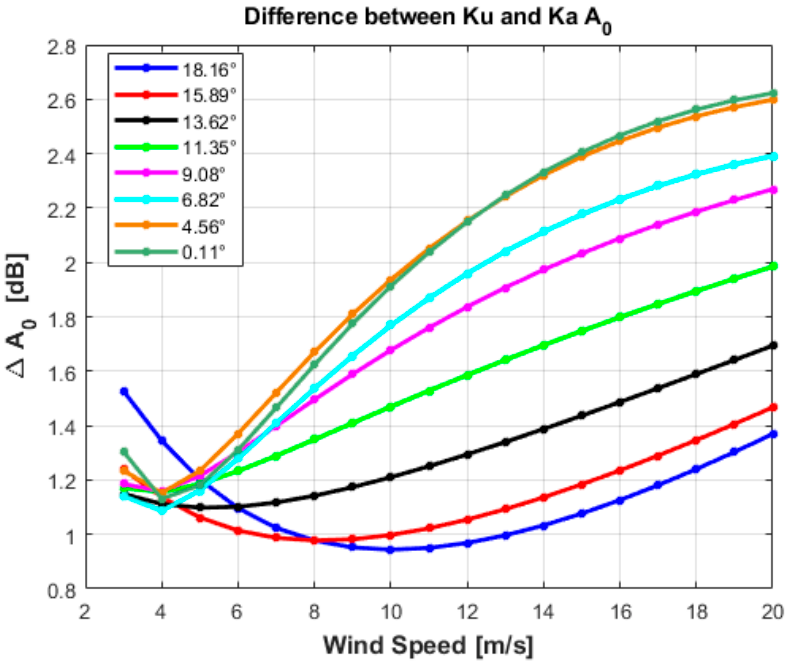
Figure 5. Difference between isotropic σ 0 models (in dB) of KuPR and KaPR as a function of wind speed (3–20 ms − 1 ) at different earth incidence angles (0 ° –18.1 ° ).